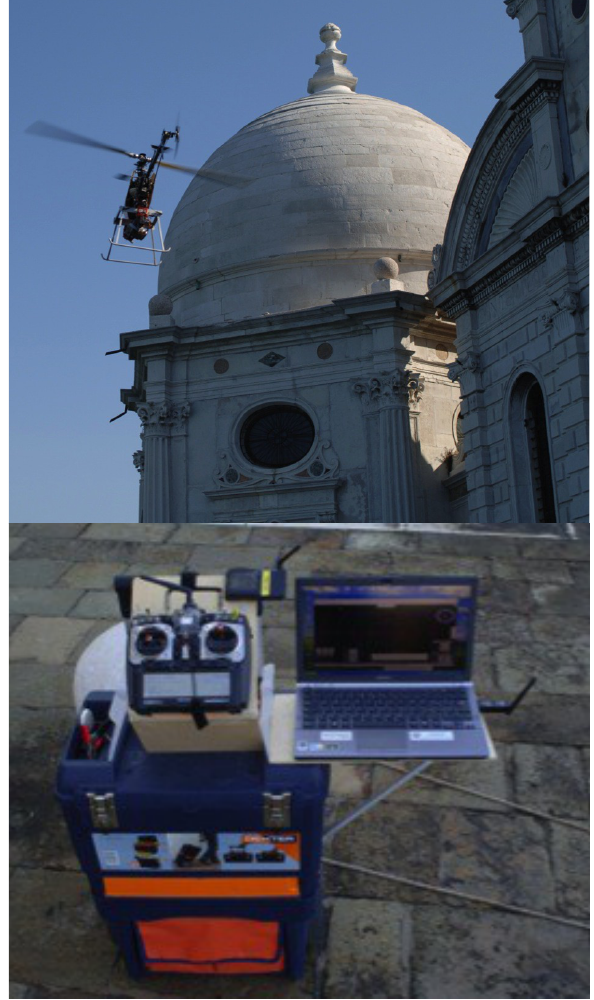
Figure 5. the Align Trex helicopter, equipped with GPS and the Sony Nex camera and its ground control